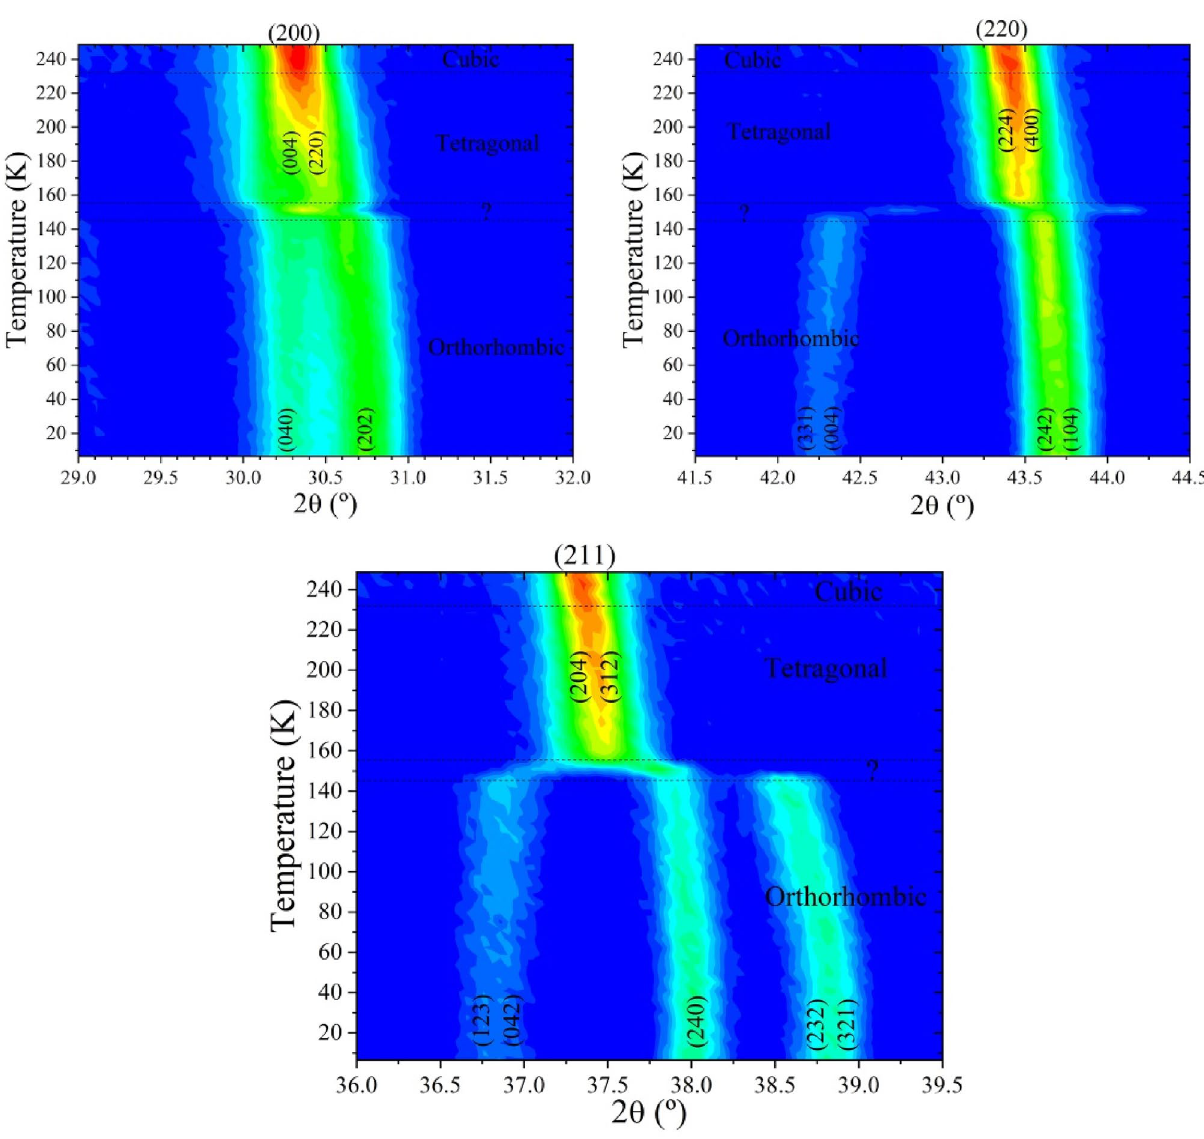
Figure 5. Thermal evolution of neutron diffraction patterns from 2 to 250